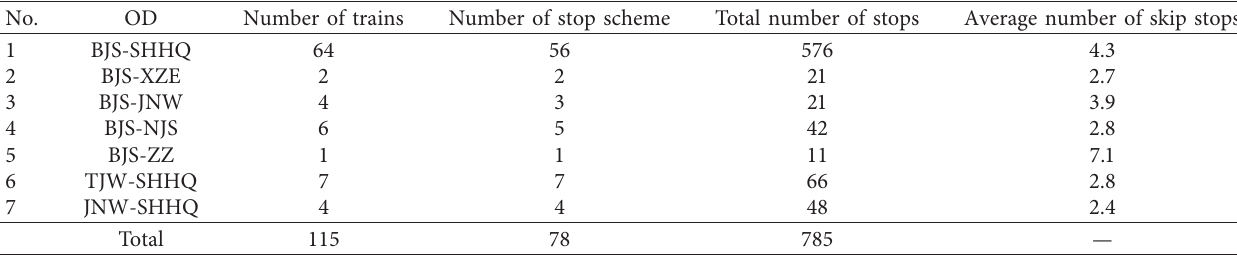
Table 3: Operation information for the Beijing-Shanghai high-speed railway.